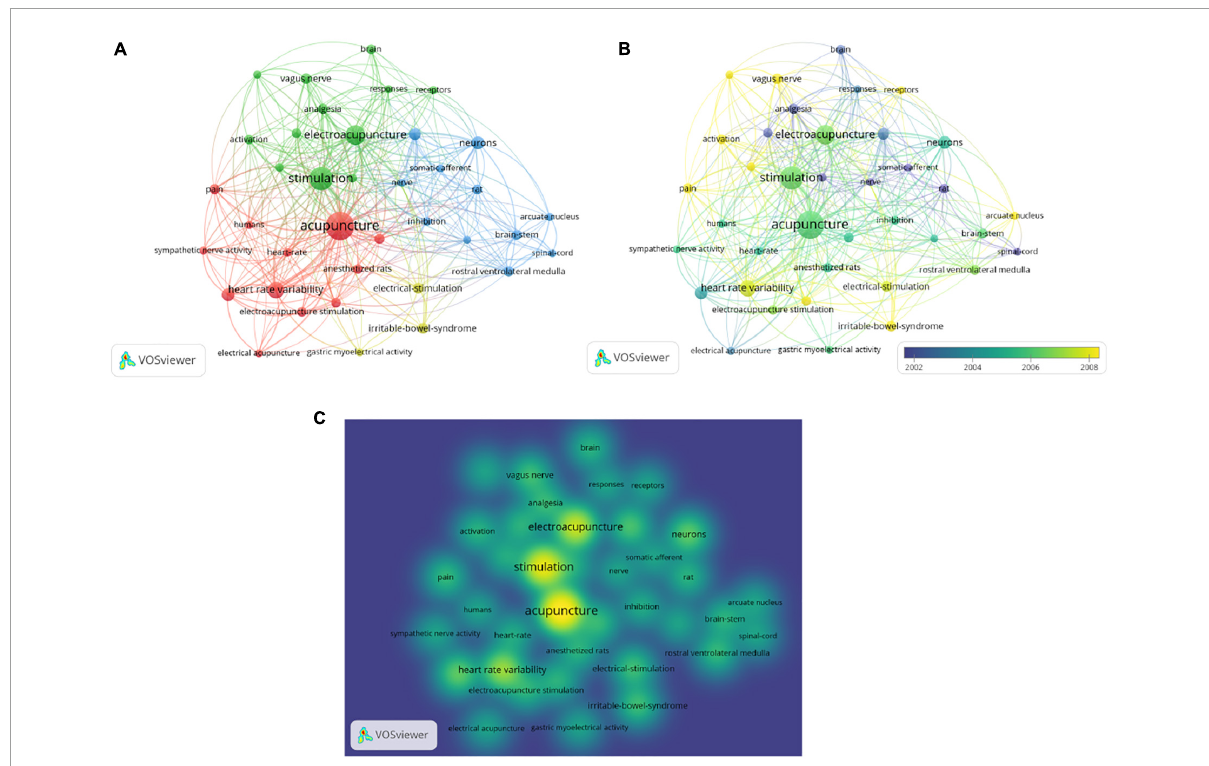
FIGURE5 Co-occurrence analysis of keywords. (A) Mapping of keywords of studies. (B) Distribution of keywords according to average publication year (blue: earlier, yellow: later). (C) Distribution of keywords according to the mean frequency of appearance. Keywords in yellow occurred with the highest